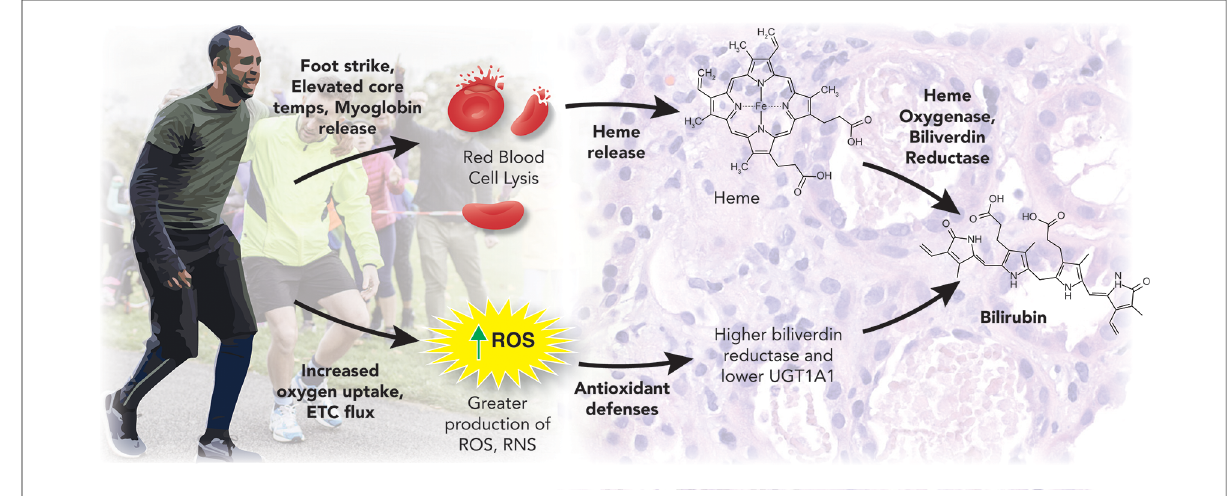
FIGURE 2 Exercise and bilirubin production. This fi gure was created by Matthew Hazzard at the University of Kentucky College of